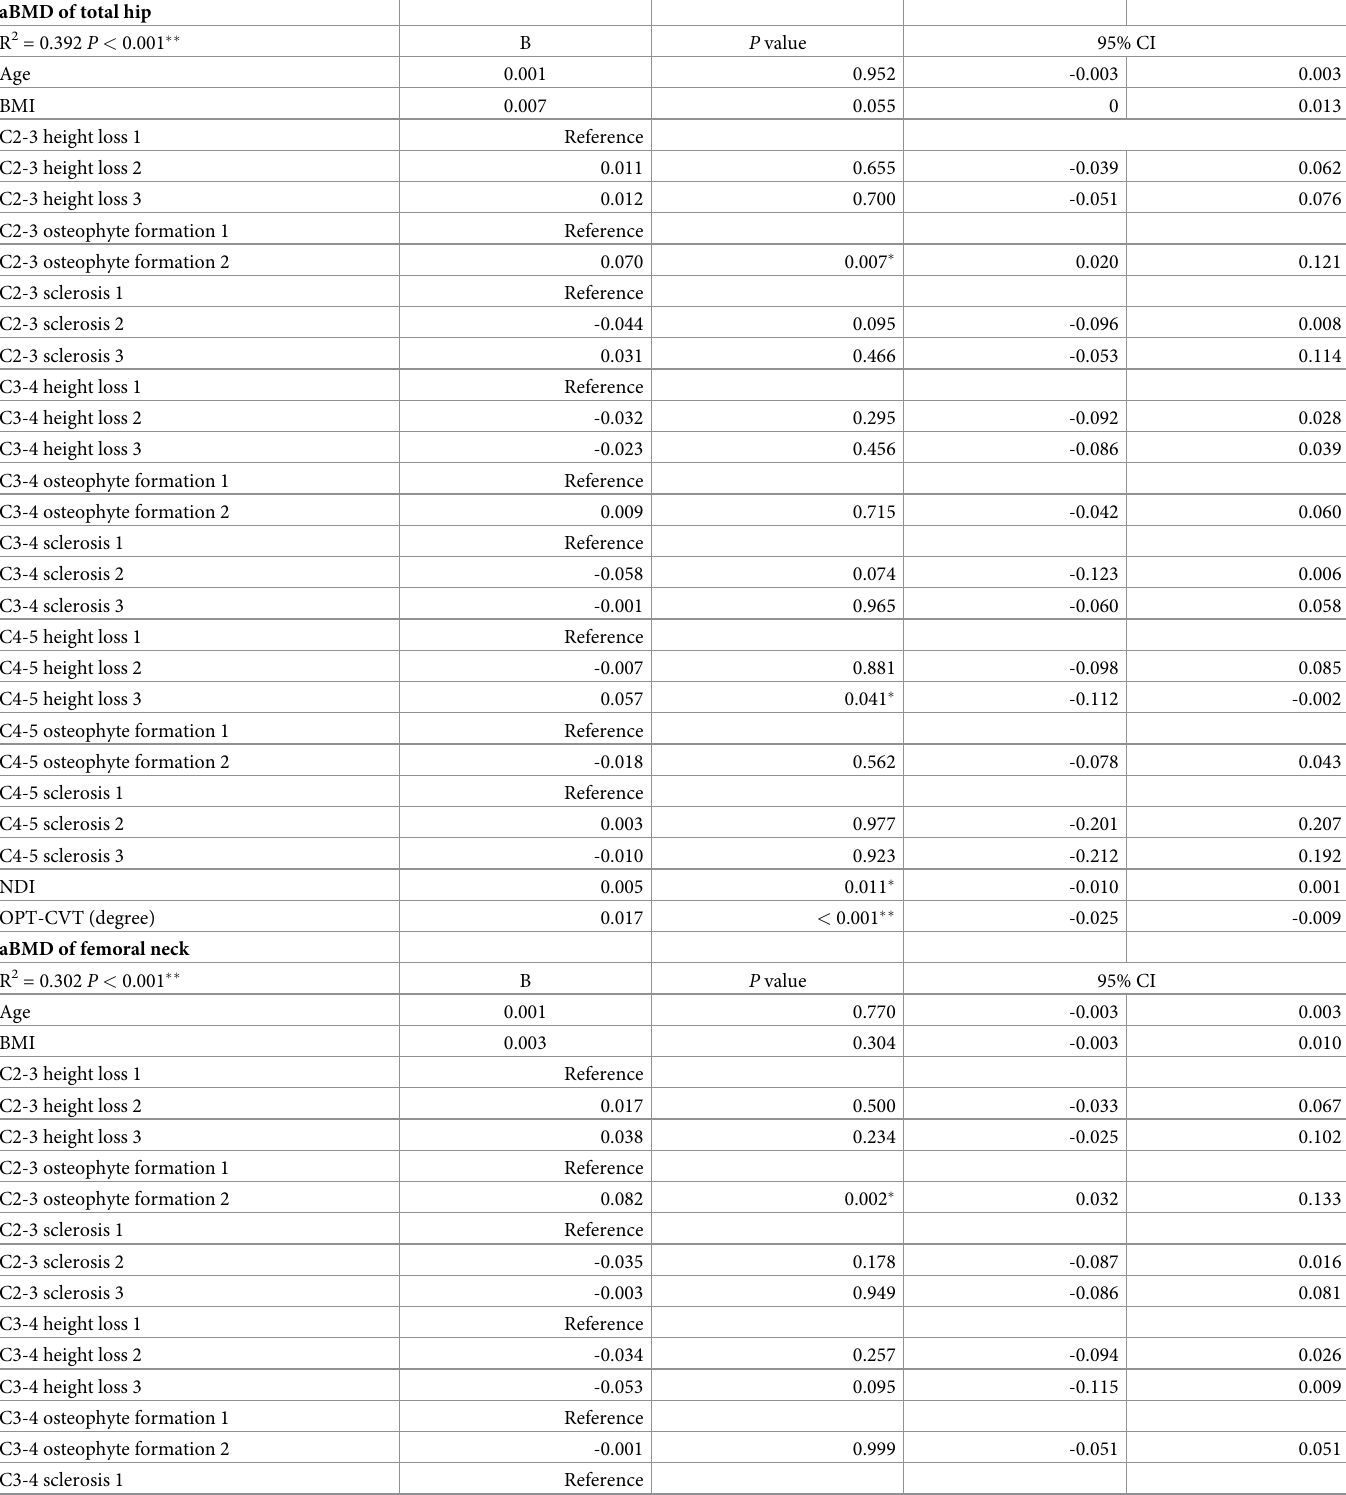
Table 4. Multivariate linear regression analysis for the bone mineral